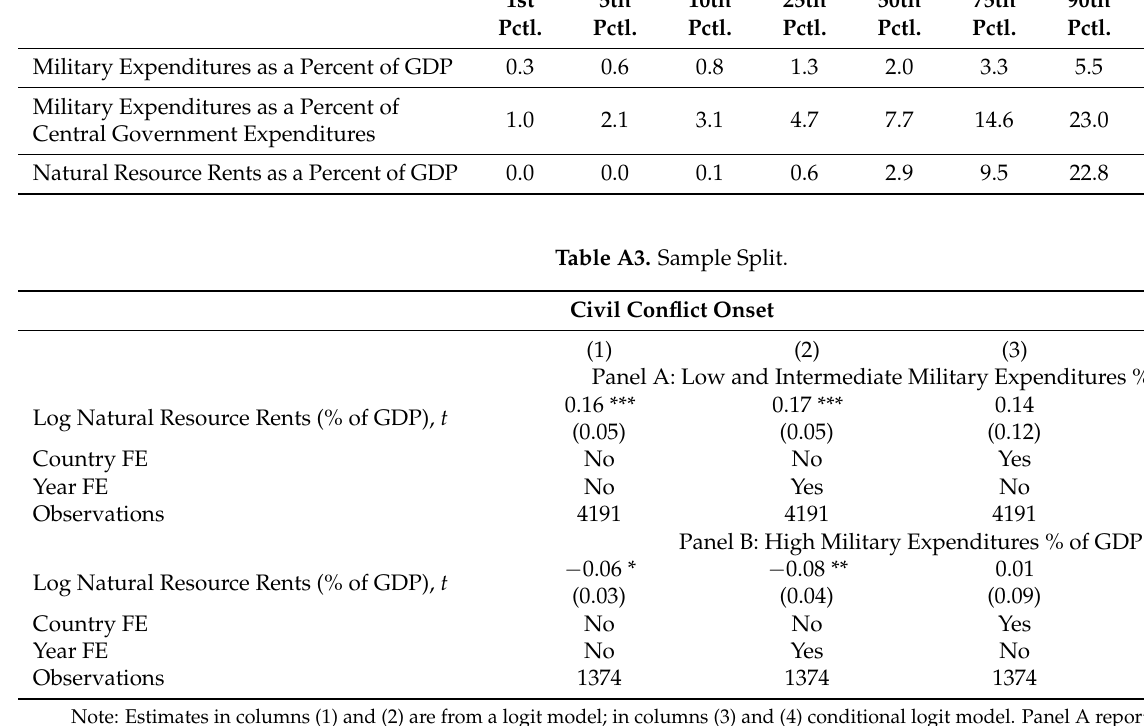
1st 5th 10th 25th 50th 75th Pctl. Pctl. Pctl. Pctl. Pctl. Pctl. Pctl. Pctl. Pctl.